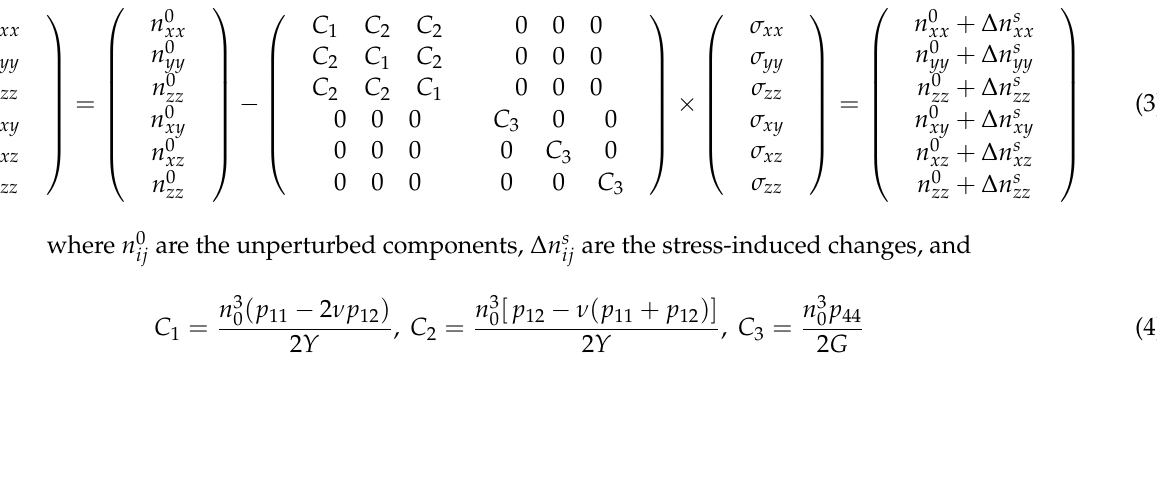
The laser cavity along the z -axis is defined through semi-reflecting mirrors at cavity facets. The TE-polarized light propagating along this direction is not affected by the intrinsic anisotropy ∆ n 0 . Furthermore, the small refractive index changes associated with ii the photo-elastic effect do not produce any significant change to facet